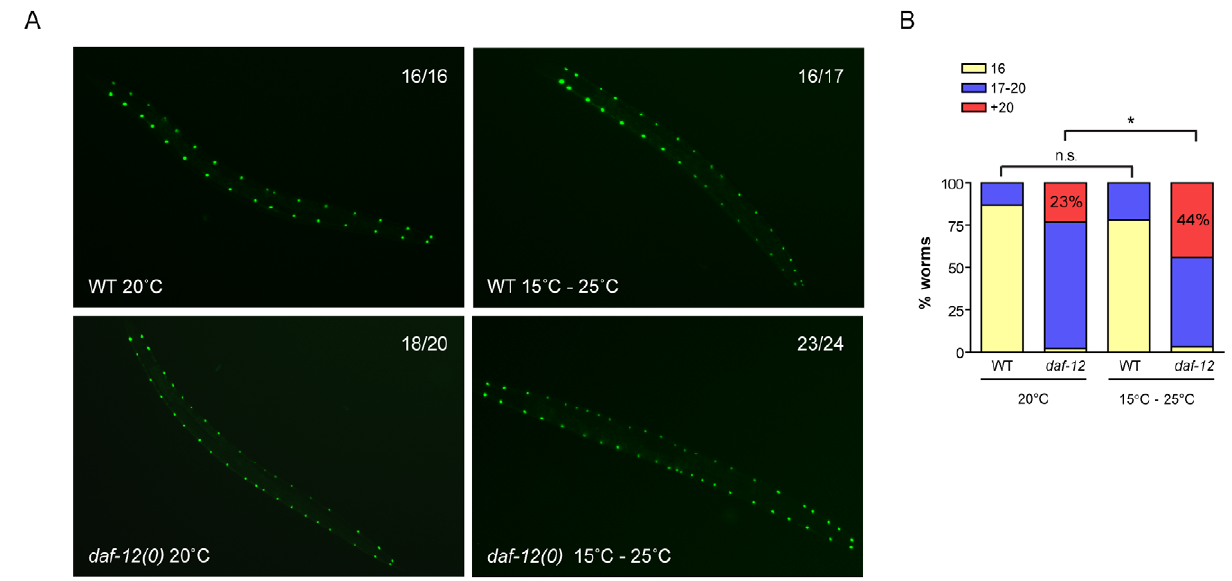
Figure 8. DAF-12 acts as a phenotypic capacitor in worms. ( A ) Images of WT or daf-12(0) worms carrying the SCM::GFP transgene that were grown at 20 u C or cycles of 15 u C–25 u C (4 hours each) until adulthood. The number of hypodermal seam cells per side is indicated in each figure. ( B ) Graph showing quantification of no, weak or strong heterochronic phenotypes. Differences were analyzed using Fisher’s exact test with SAS 9.2 software. * p ,